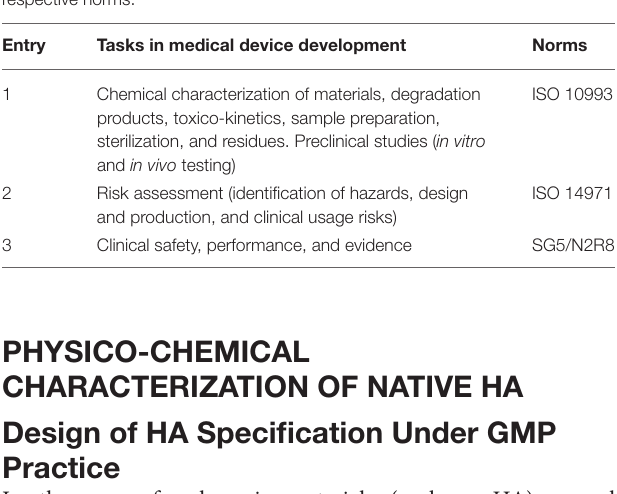
TABLE 2 | Evaluation of products requirements toward medical device with respective